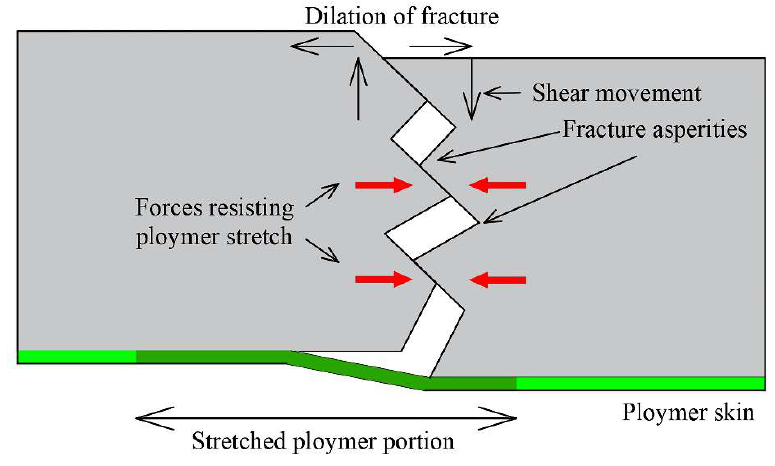
Figure 21. Shearing and dilation mechanisms of fracture surface [91].